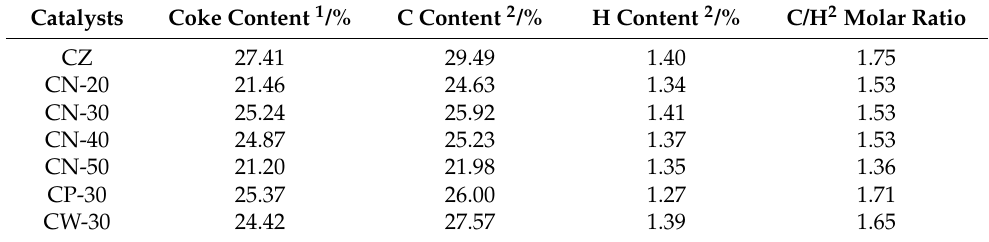
Table 4. The results of the coke, C and H content of the coke-deposited catalysts.